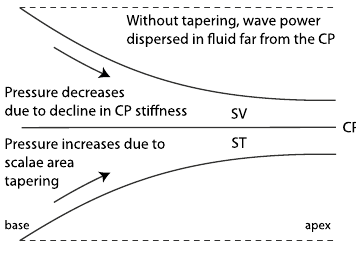
Figure 2. In the tail region of the traveling wave, the horn-like tapering of the cochlear duct boosts the intensity of the traveling wave, compensating for the spatial decay of transpartition pressure that arises from the progressive decline of CP stiffness. In a hypothetical box cochlea (dotted lines), by contrast, the wave power is dispersed throughout the larger fluid